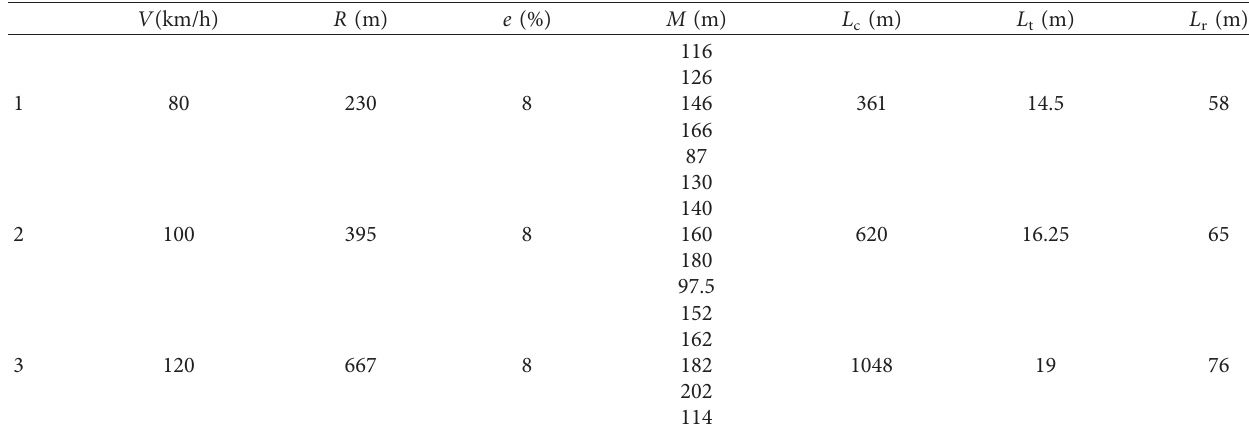
Table 2: Characteristics of reverse horizontal curves simulated in the road